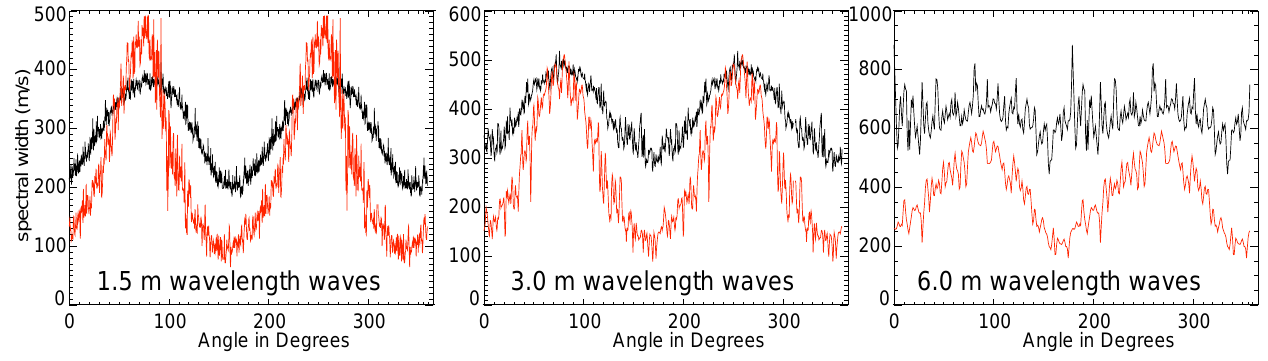
Fig. 8. Spectral widths for 3 different wavelengths ( | k | ) as a function of angle. The black lines show the second moments of the spectral information displayed in Fig. 5. The red lines show the standard deviation of a Gaussian fit to the spectra and gives a better representation of the spectral width.